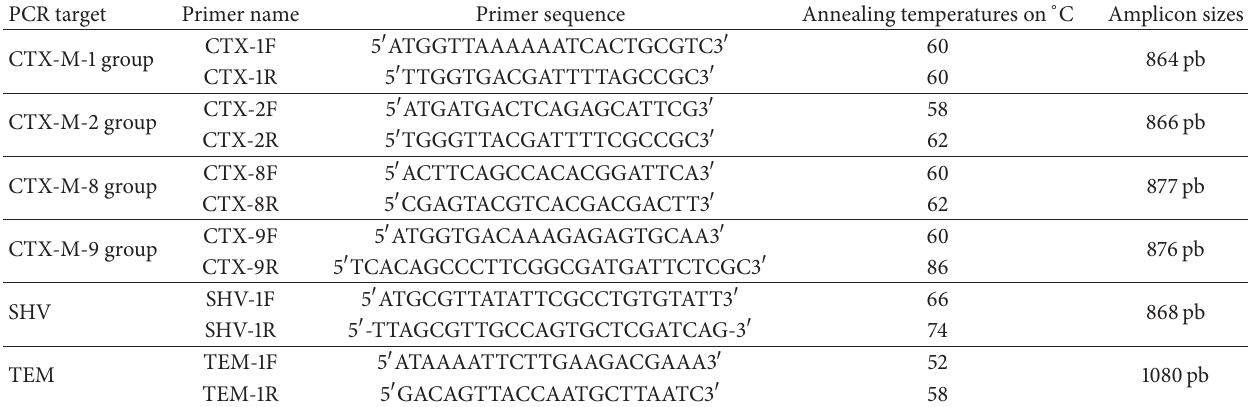
Table 1: Sequences of the primers used to detect 𝛽 -lactamases